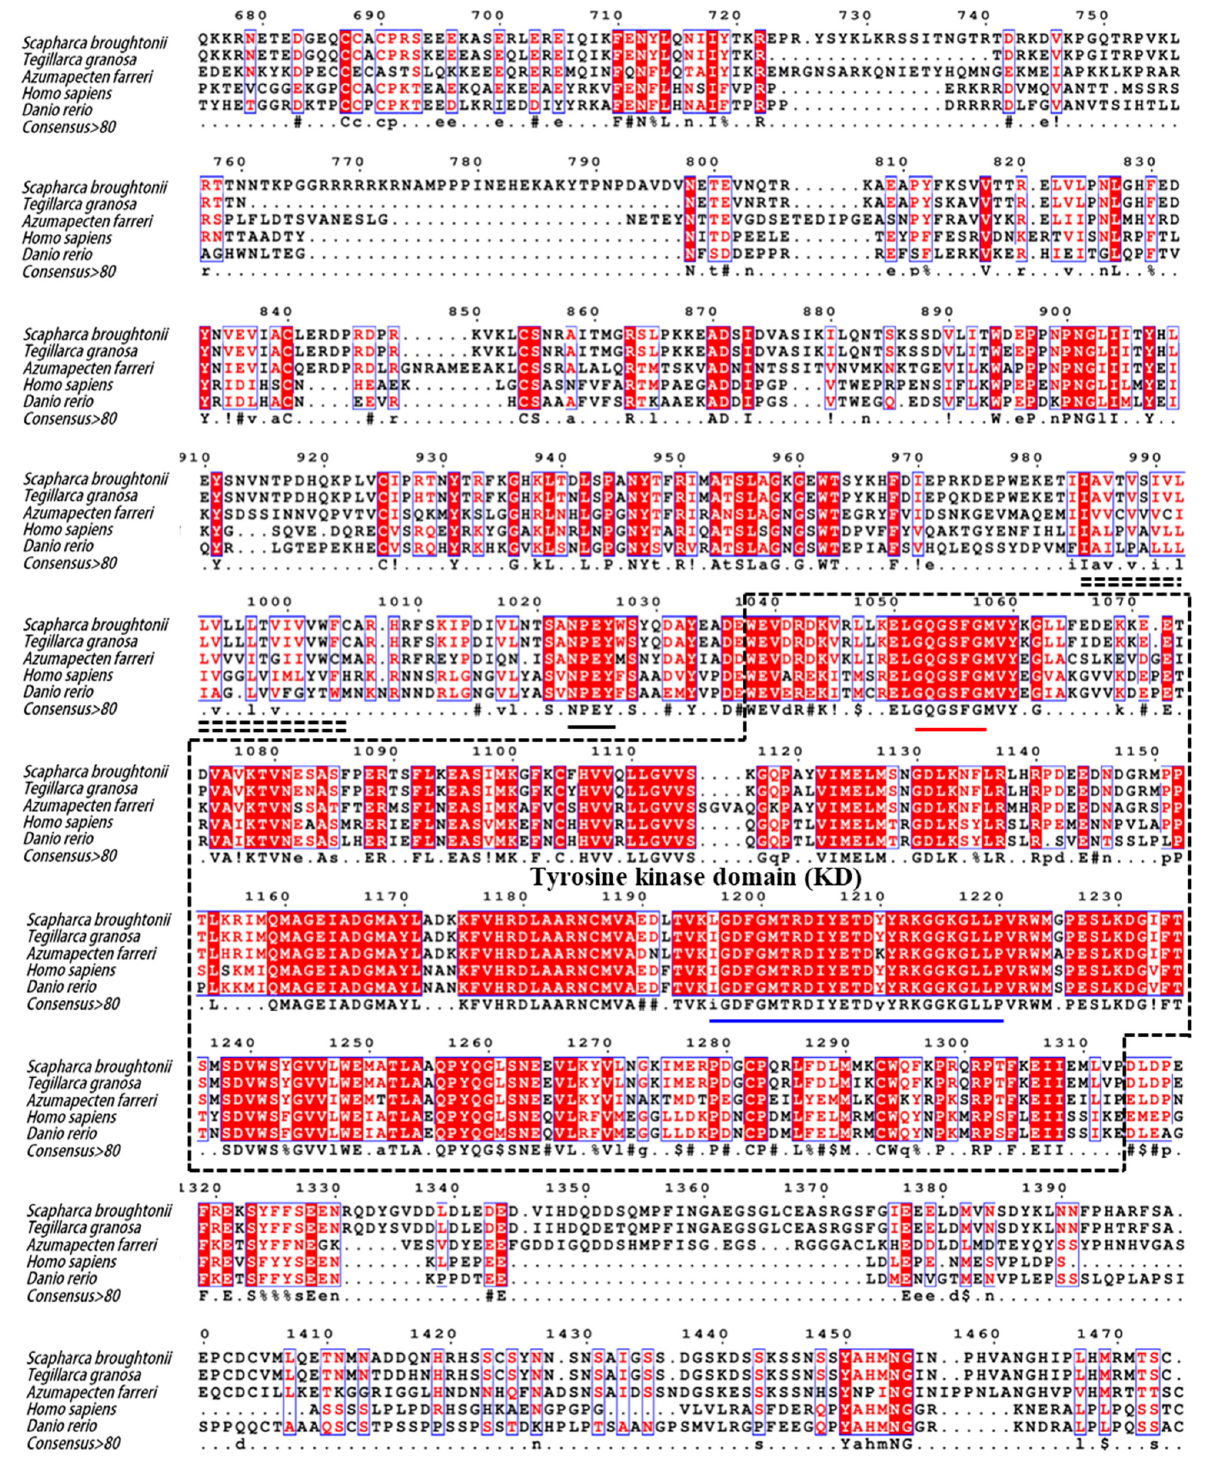
Figure 3. Multiple sequence alignment of Sb IGF-1R with other IGF-1Rs from various species. The amino acid number above the sequence refers to Sb IGF-1R. Identical and similar amino acid residues are indicated with minuscules. The double-dashed amino acid fragments represent the transmem- brane domain. The ATP binding motif (red), the activation loop (blue), and the NPXY motif (black) are underlined in different colors. In the consensus sequence: upper case is identity, lower case is consensus level > 0.5, ! is stands for I or V, $ for L or M, % for F or Y, # for N, D, Q, E, B or Z. The GenBank accession numbers of the aligned sequences are as follows: Tegillarca granosa (ALS40479.1) , Azumapecten farreri (QFR39799.1) , Homo sapiens (P08069.1) , Danio rerio (NP_694501.1) .